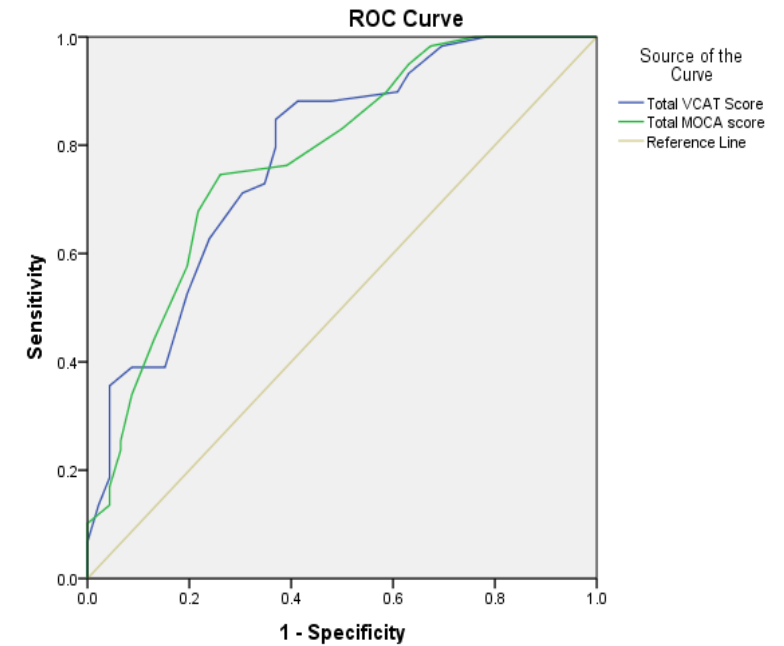
Figure 2. Receiver operating characteristic curves: area under the curve (AUC) for discriminating between MCI and mild dementia (AD + VAD) participants on VCAT and MoCA scores. MoCA Montreal Cognitive Assessment, VCAT Visual Cognitive Assessment Test.